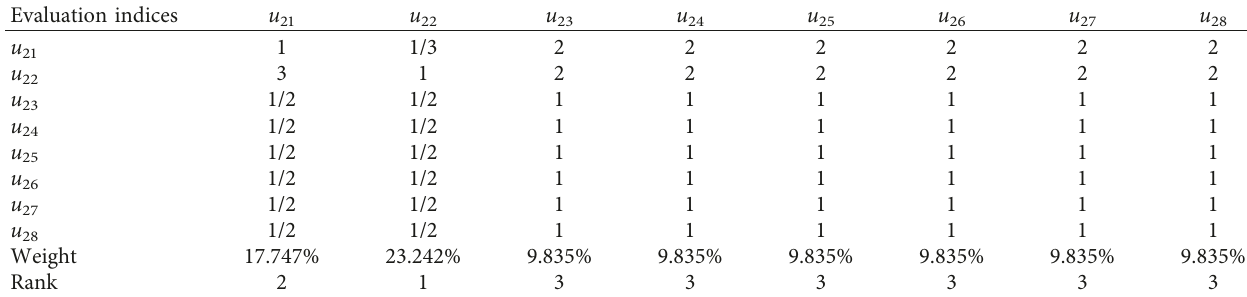
Table 5: Weights and rank of the environmental conditions.